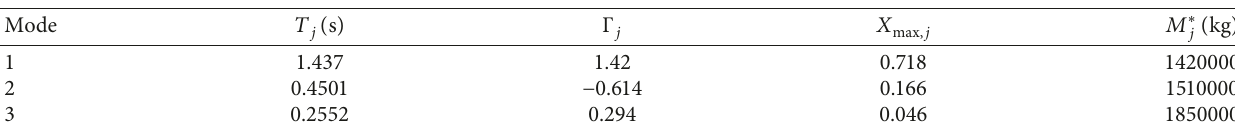
Table 4: Modal factors.